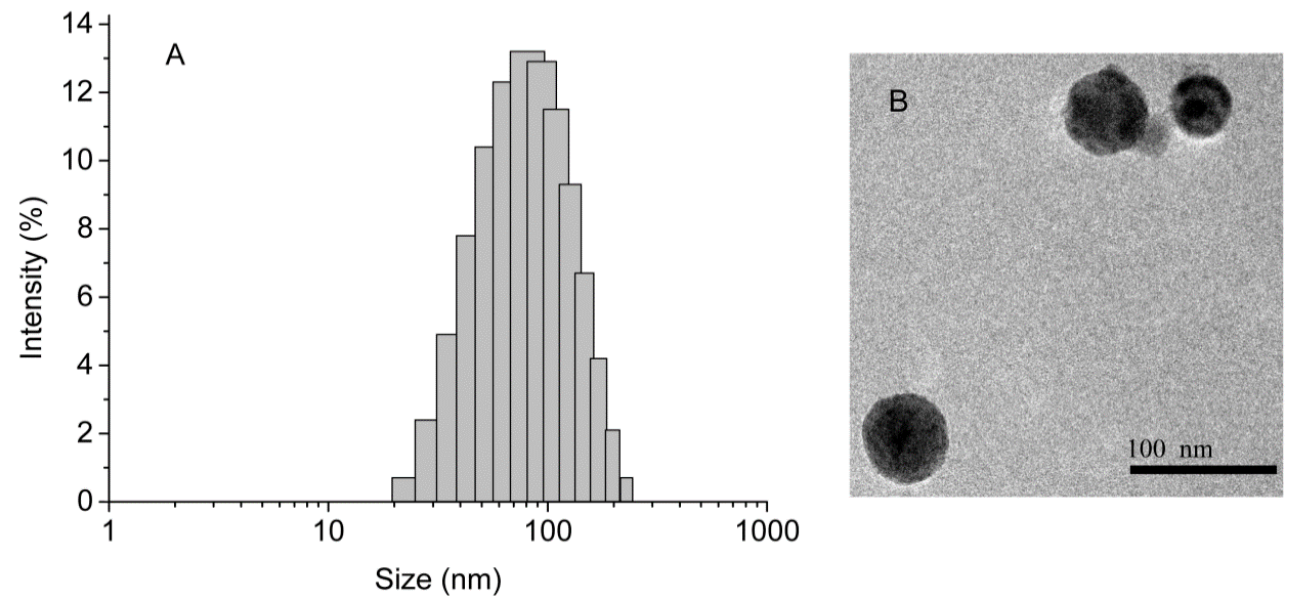
Figure 5. Size distribution and TEM image of the micelles from m PEG-HTO- m PEG-2.